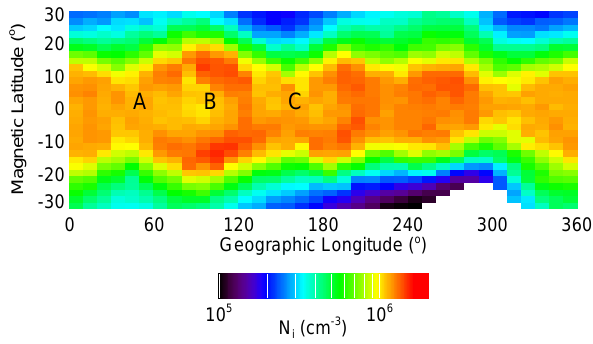
Fig. 1. The daytime longitudinal plasma density structure observed from ROCSAT-1. The mean density at each 10 ◦ × 2 ◦ longitude- latitude bin was calculated using the ROCSAT-1 data at 12:00– 14:00LT during equinox (March, April, September, and October) in